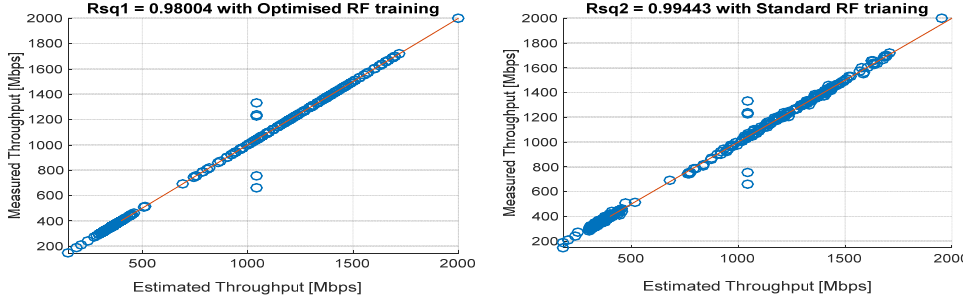
Figure 17. Predicted throughput quality correlation performance of the proposed RF-LS-BPT model and standard RF model at 160 m distance. Table 4. Proposed RF-LS-BPT and standard RF regression model accuracy for training. Accuracy